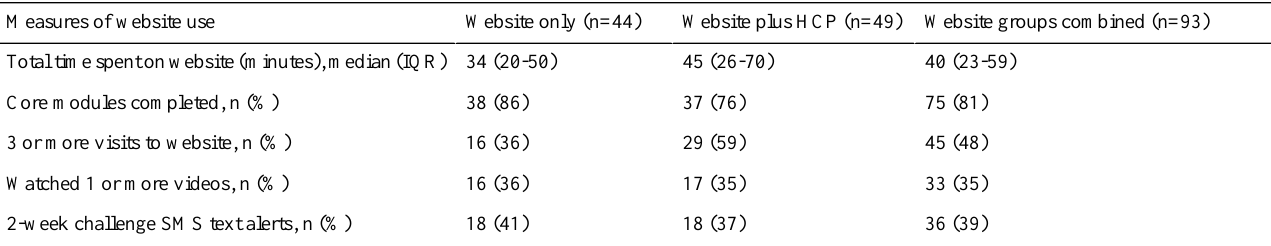
Table 3. Intervention